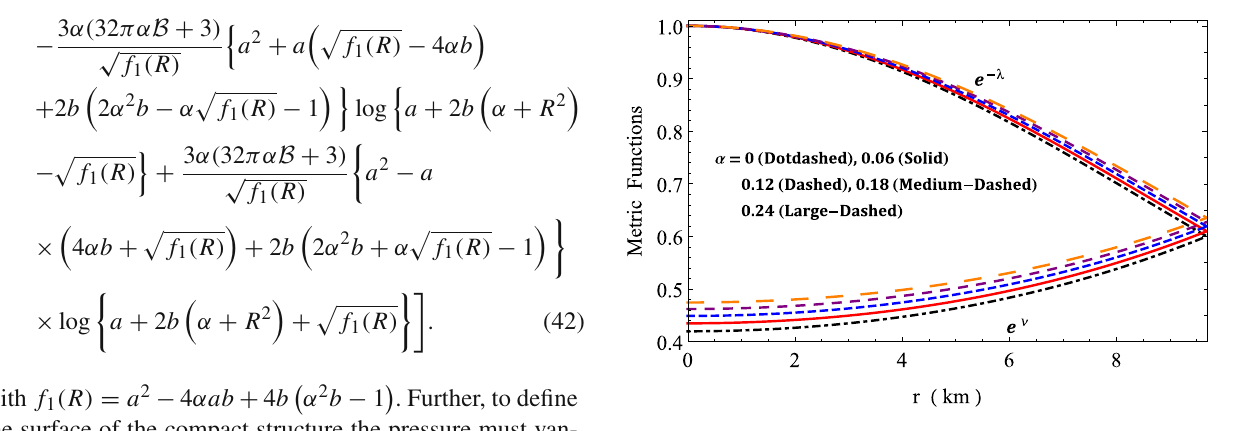
Fig. 1 Variation metric potentials with r for M = 1 . 97 M (cid:3) , R = 9 . 69 km , b = 0 . 000015 / km 4 and matching of boundary at the